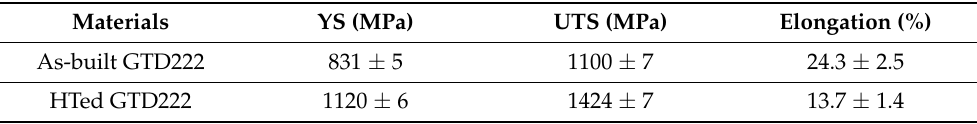
Table 1. The mechanical properties of the as-built and HTed GTD222. Yield strength (YS), ultimate tensile strength